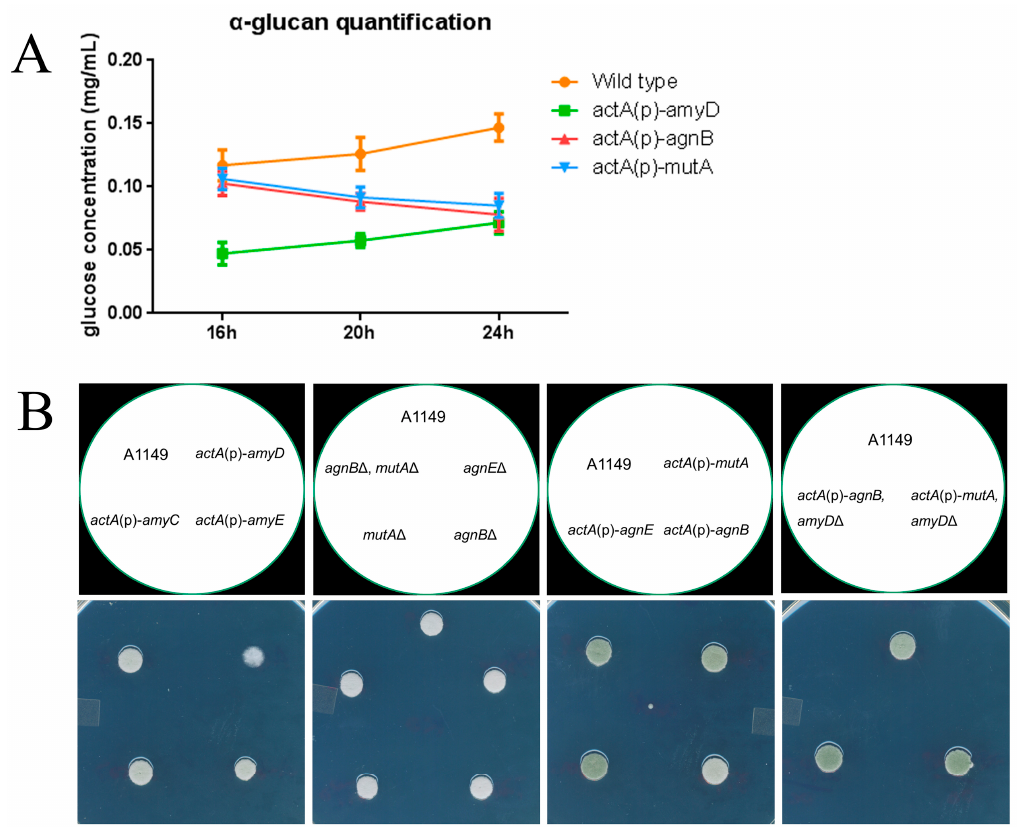
Figure 5. Dynamics of α -glucan accumulation and its impact on CFW sensitivity. ( A ) Dynamics of α -glucan accumulation in each strain with time. 2 × 10 7 spores of each strain were inoculated in 100 mL complete medium. Samples were grown in flasks at 30 ◦ C with 150 rpm for 16 h, 20 h, and 24 h, respectively. α -glucan was extracted from 1 mg of dry cell wall, and then digested to glucose and quantified by an anthrone assay. Wild-type and actA (p)- amyD showed the same increasing trend from 16 h to 24 h, except the glucose concentration in actA (p)- amyD was much lower than that of the wild-type at each time point. The actA (p)- agnB and actA (p)- mutA had the same decreasing trend from 16 h to 24 h; ( B ) freshly harvested conidia (10 5 ) of each strain were inoculated on 50 µ g/mL CFW plates and the plates were incubated at 30 ◦ C for 48 h. Only actA (p)- amyD showed delayed germination and growth.